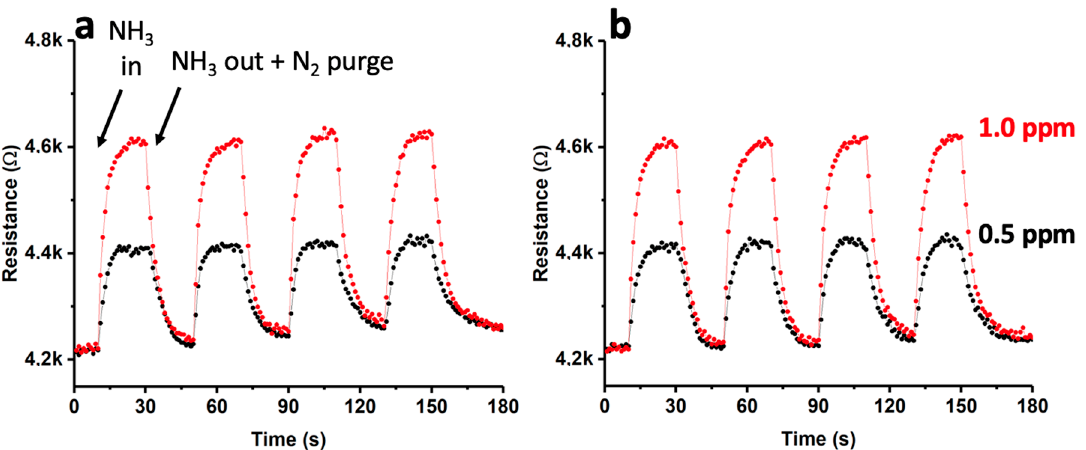
Figure 10. Dynamic response curves for the Au(chemical)-SWCNT composite gas sensor towards NH 3 (0.5 ppm and 1 ppm) at 25 °C ( a ) and 140 °C ( b ).